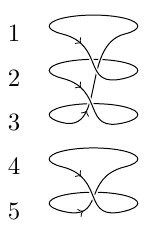
Figure 3 . The closed string con(cid:12)guration corresponding to the permutation (cid:27) : 1 1 ; 4 5 ; 5 4. The cycle lengths (3 ; 2) correspond to the winding numbers of the closed ! !